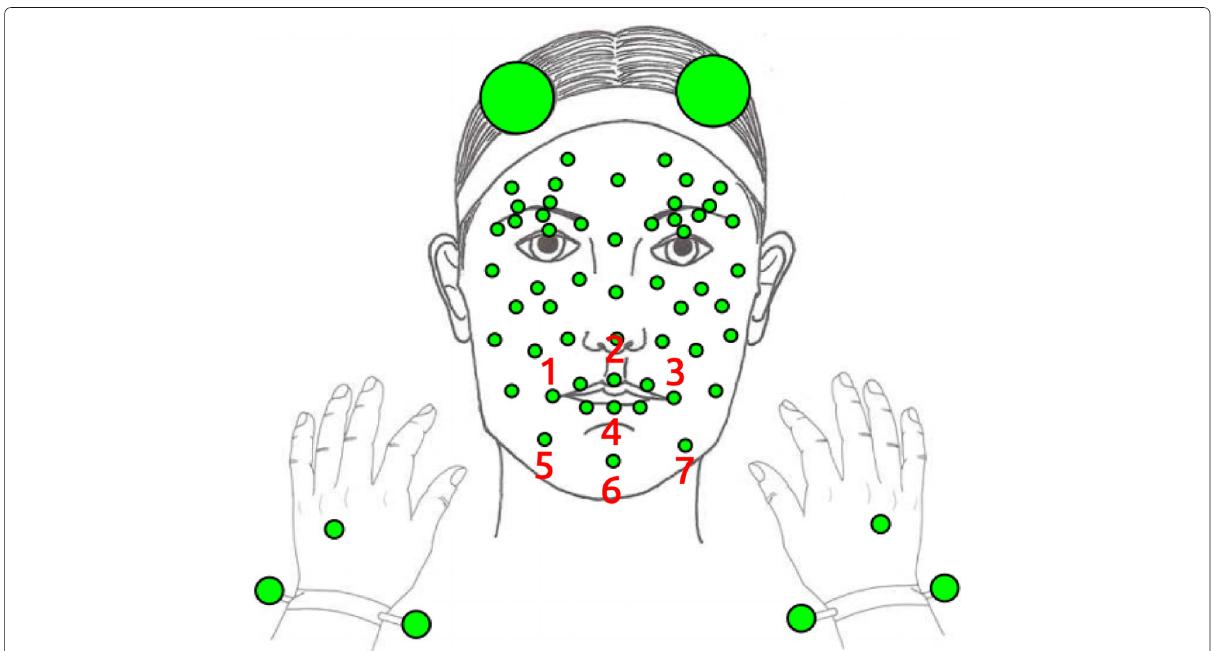
Fig. 3 Arrangement of facial markers in the USC IEMOCAP database. The markers used in this study are numbered from 1 to 7. Image obtained from